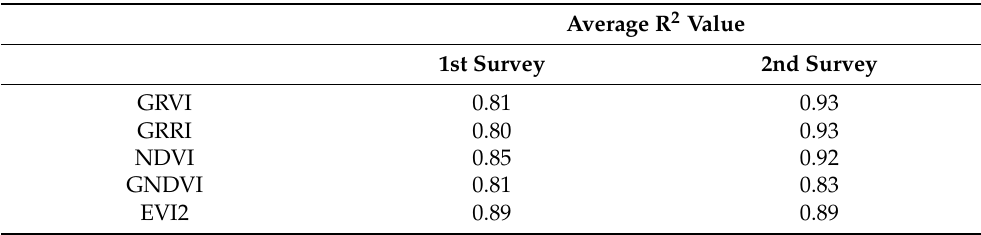
Table 6. Average determination coefficients of linear regression for DL against each VI for investi- gated locations.